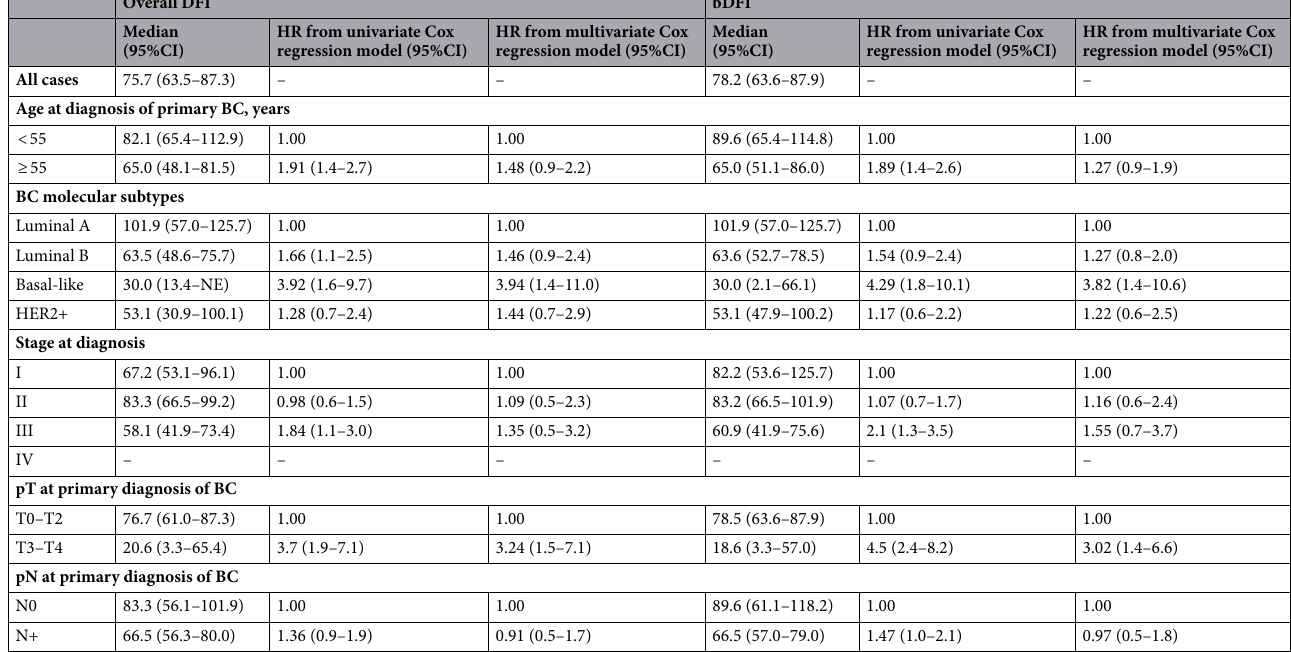
Table 5. Median DFI and independent risk factors for metastasis. DFI disease-free interval, bDFI bone disease-free interval, HR hazard ratio, BC breast cancer, NE not evaluable from statistical software, pT primary tumour, pN pathological lymph